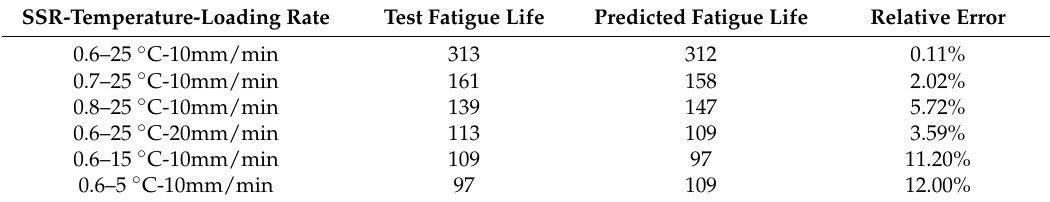
Table 8. Contrast results of fatigue